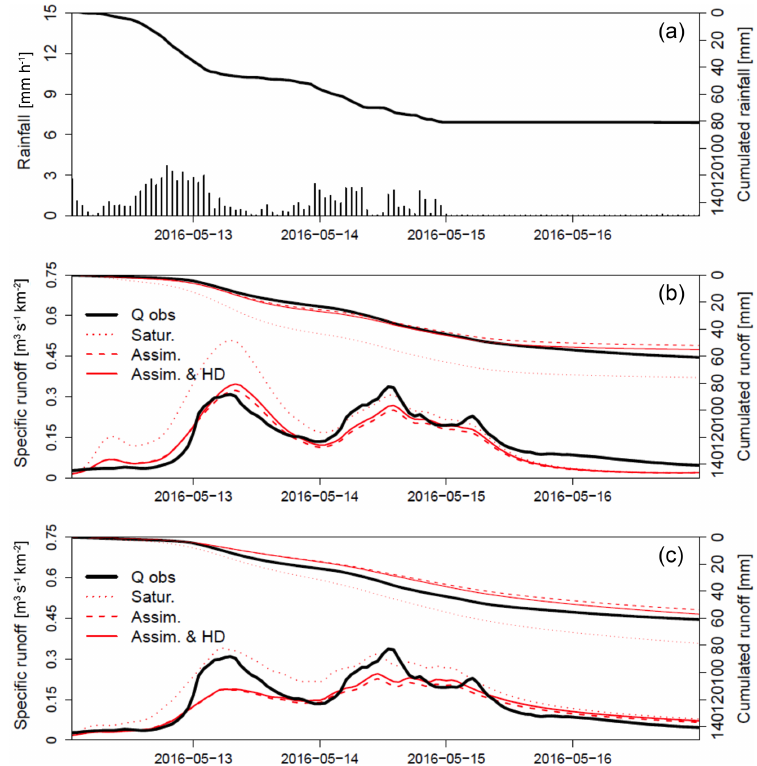
Figure A3. Influence of the soil moisture initial conditions on the simulated runoff for the Emme up to Emmenmatt during the long- duration event of May 2016 obtained with the bottom-up (a) and top-down (b) set-up. The simulated hydrographs refer to the first run of the Monte Carlo simulation performed with SF07 map and with Combiprecip as forcing. The saturated initial conditions led to a significant overestimation of runoff at the beginning of the simulations, whereas the hydrological downscaling barely affected the simulation